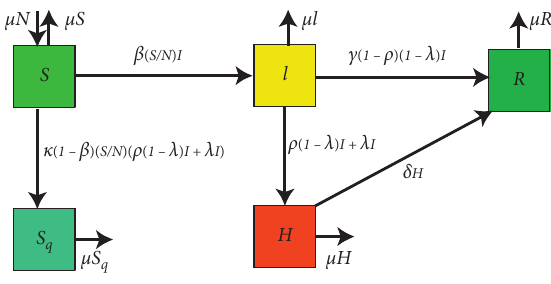
Figure 1: General transfer diagram of the